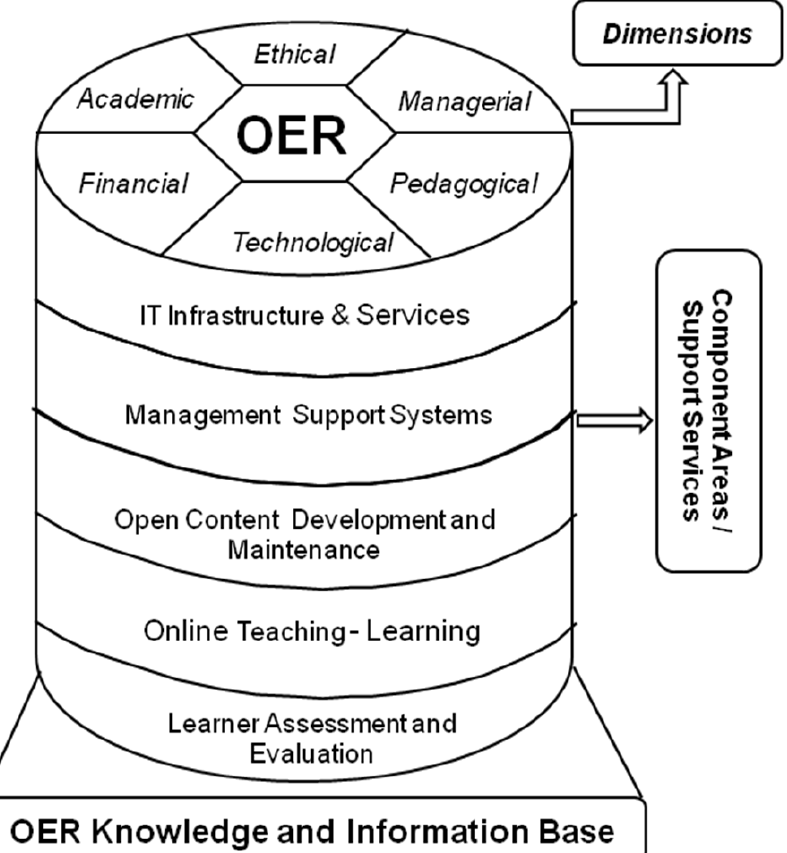
Figure 1 .The OER architecture